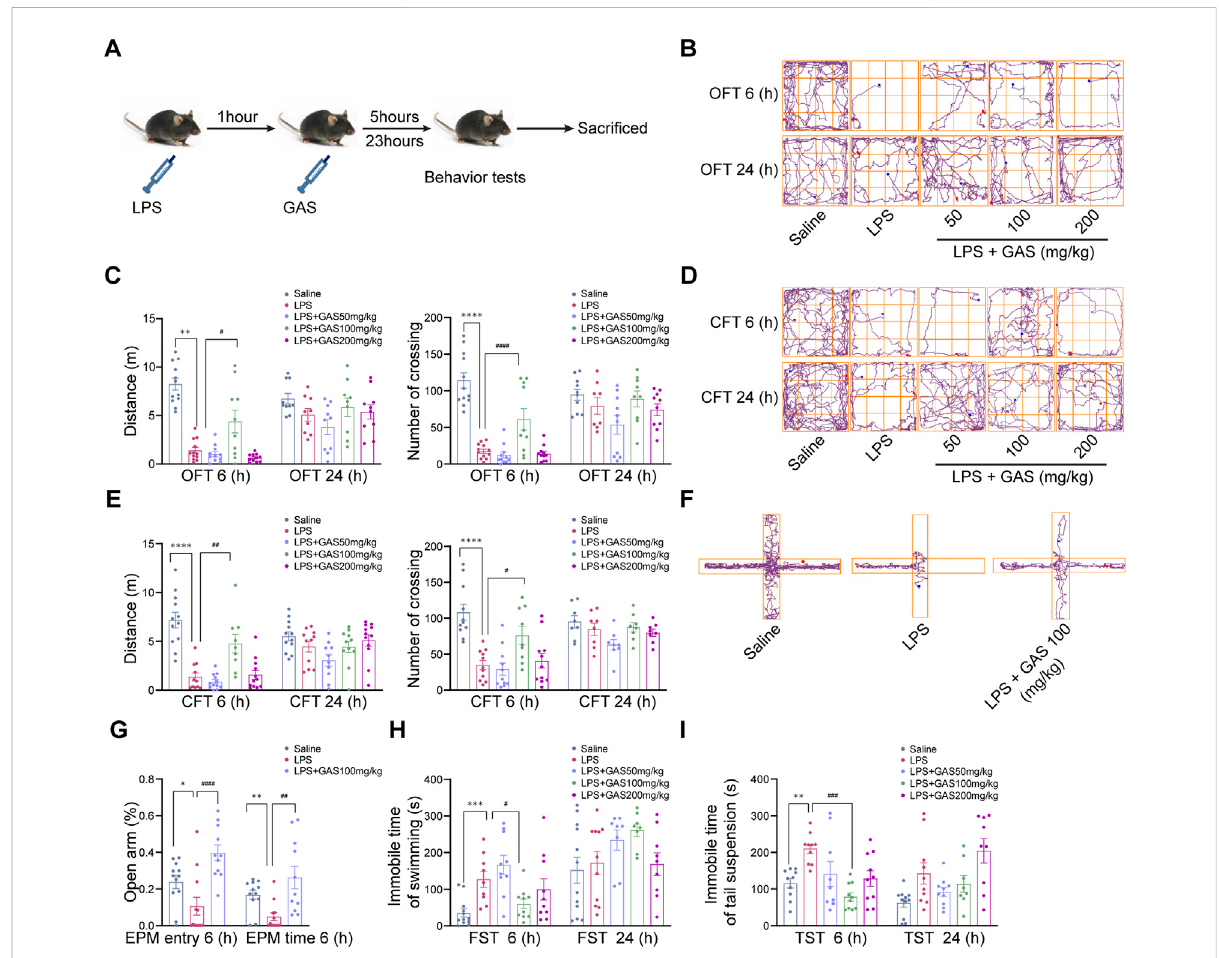
FIGURE 1 Effects of GAS on locomotor activity and depressive-anxiety- like behaviors after 6 and 24 h of LPS treated mice. (A) This part of the experimental fl owchart. (B,C) Thetrackmaps,totaldistancetraveled,andcrossing linesduring5 minintheOFT. (D,E) Thetrackmaps,totaldistance traveled, and crossing lines during 5 min in the CFT. (F,G) The track maps, the ratio of the entry and time spent in the open arms in the EPM. (H) The immobiletimeofswimmingfor6 minintheFST. (I) Theimmobiletimeofsuspensionduring6 minintheTST.Alldataareexpressedasmeans± SEM for twelve mice in each group. **** p < 0.0001, *** p < 0.001, ** p < 0.01, * p < 0.05 versus respective saline group; #### p < 0.0001, ### p < 0.001, ## p < 0.01, # p < 0.05 versus LPS group. LPS, lipopolysaccharide; GAS, gastrodin; OFT, open- fi eld test; CFT, close- fi eld test; FST, forced swimming test; TST, tail suspension test; EPM, elevated plus